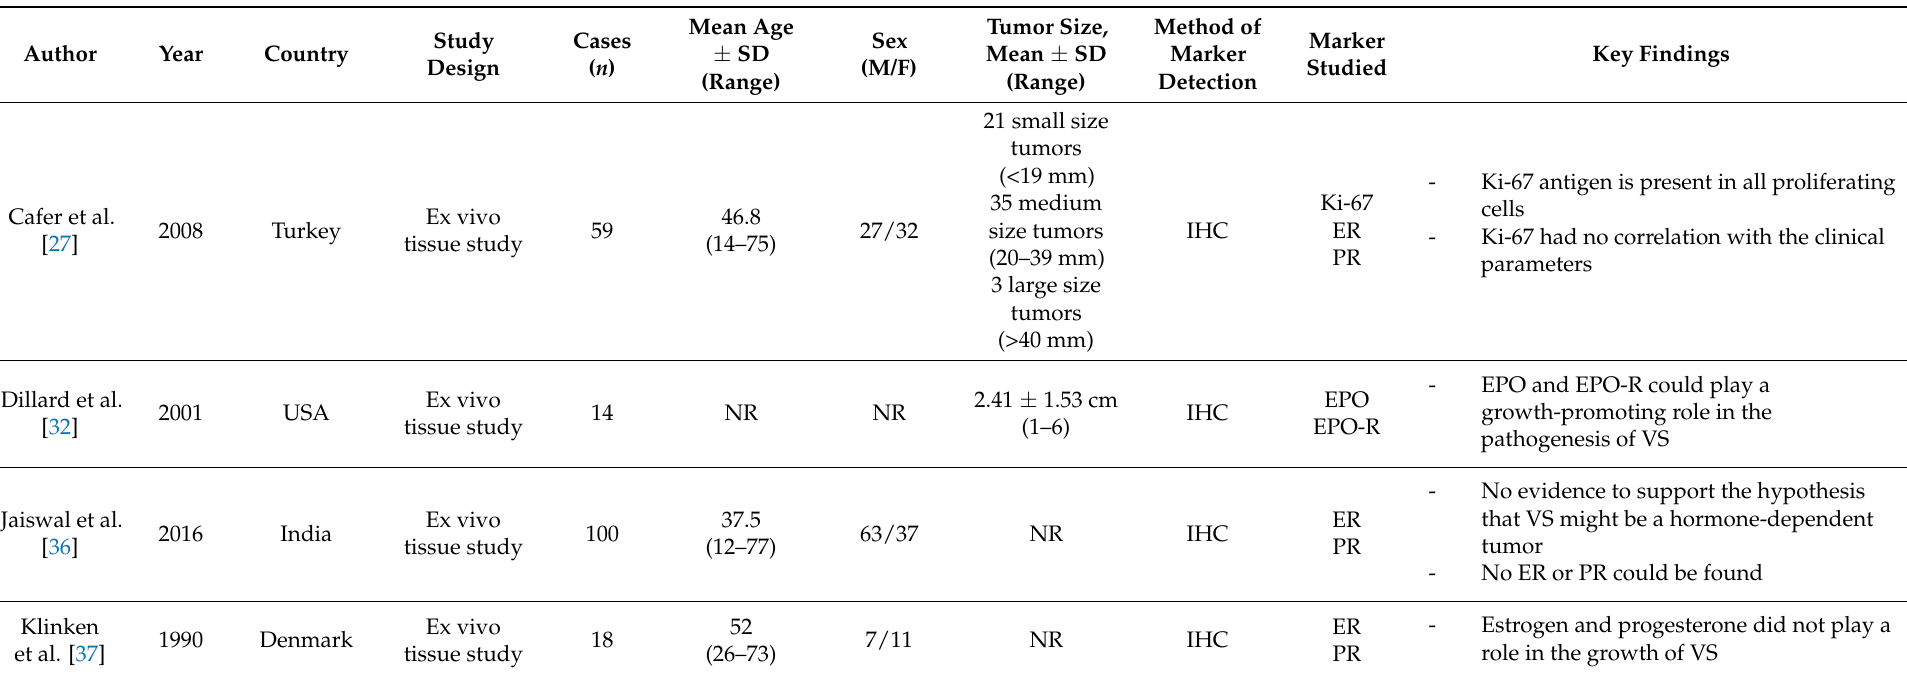
Table 6. Studies examining the role of hormone receptors in sporadic vestibular